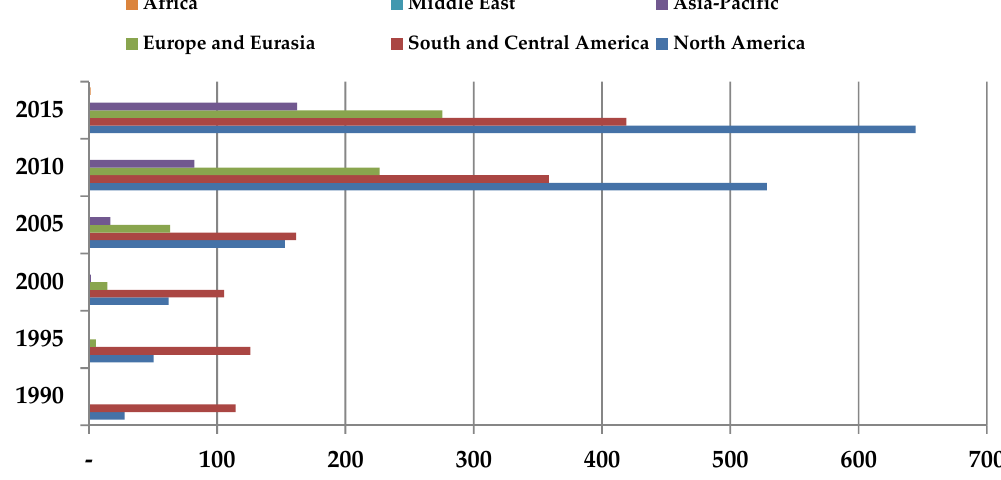
Figure 2. Global biofuel production by region (thousand barrels per day). Data adapted from [8].